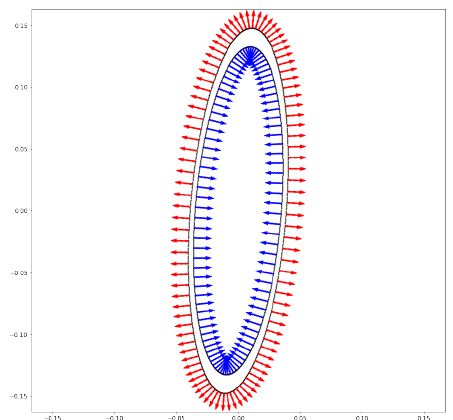
Figure 6. In the figure some upward/downward outgoing gradients are shown: the blue internal ones are downward outgoing gradients calculated on points x on the internal ellipsoid with N f , i ( x ) = N min while the external red ones are upward outgoing gradients calculated on points x on the external ellipsoid with N f , i ( x ) = N max f